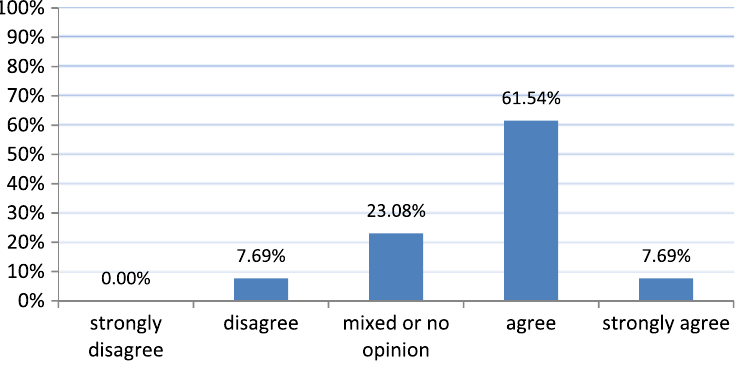
Figure 6. The culture of the university at all levels is one which embraces change and